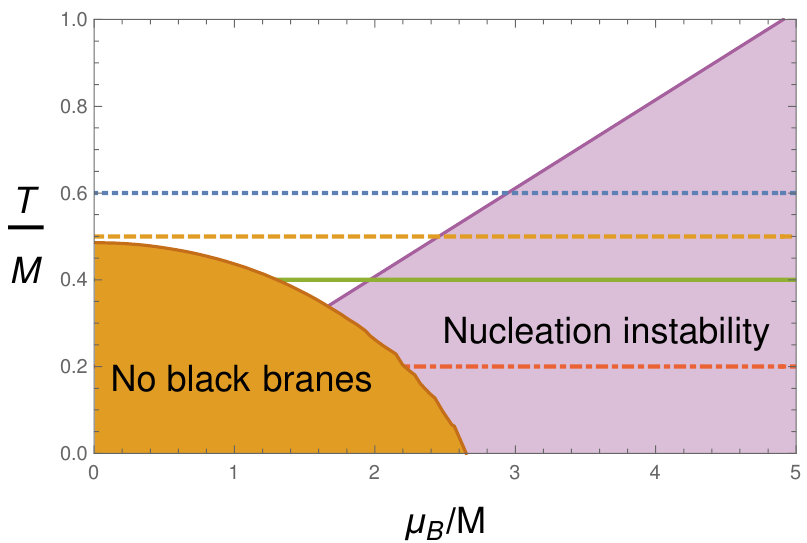
Figure 2 . The phase diagram. Within the orange region we (cid:12)nd no black brane solutions. Within the purple region the dominant black brane solutions are unstable to brane nucleation. The four horizontal lines correspond to the curves in (cid:12)gure 4.